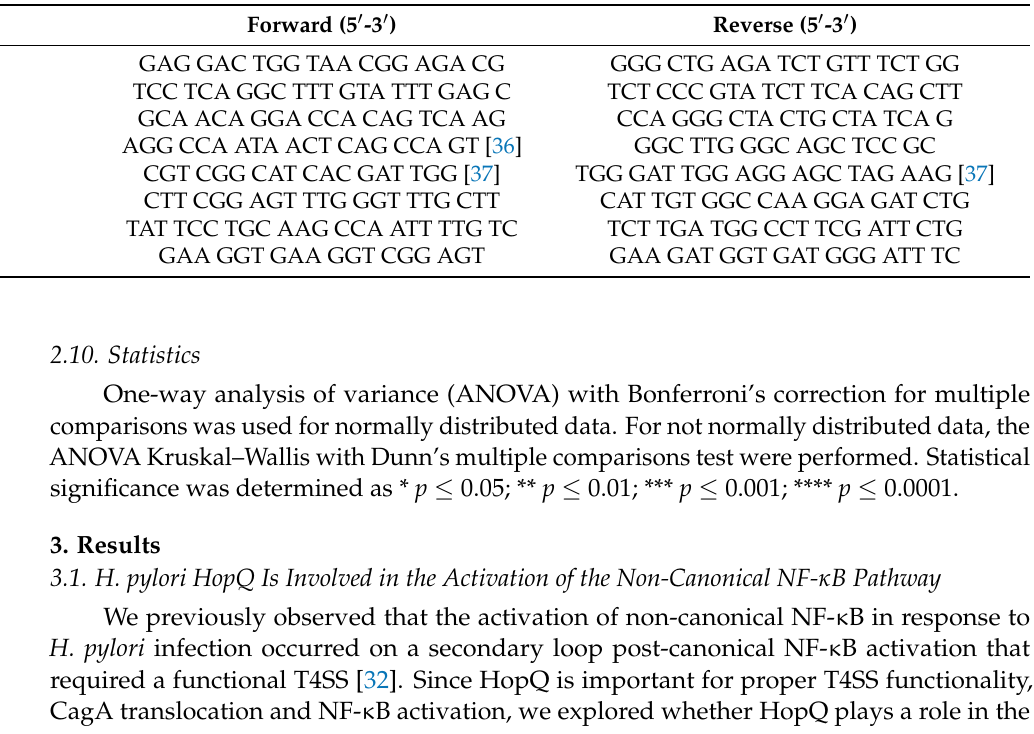
Table 1. List of human qPCR